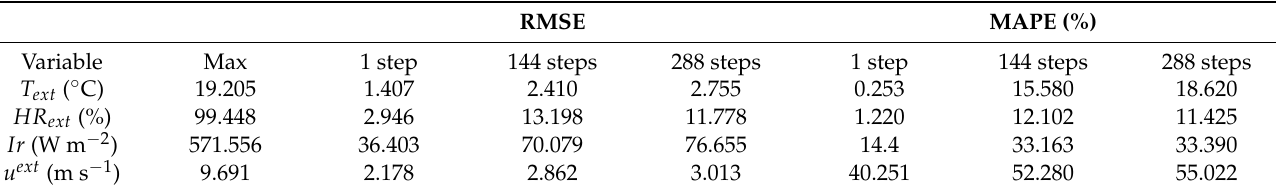
Table 2. Prediction performance based on the test data. RMSE MAPE